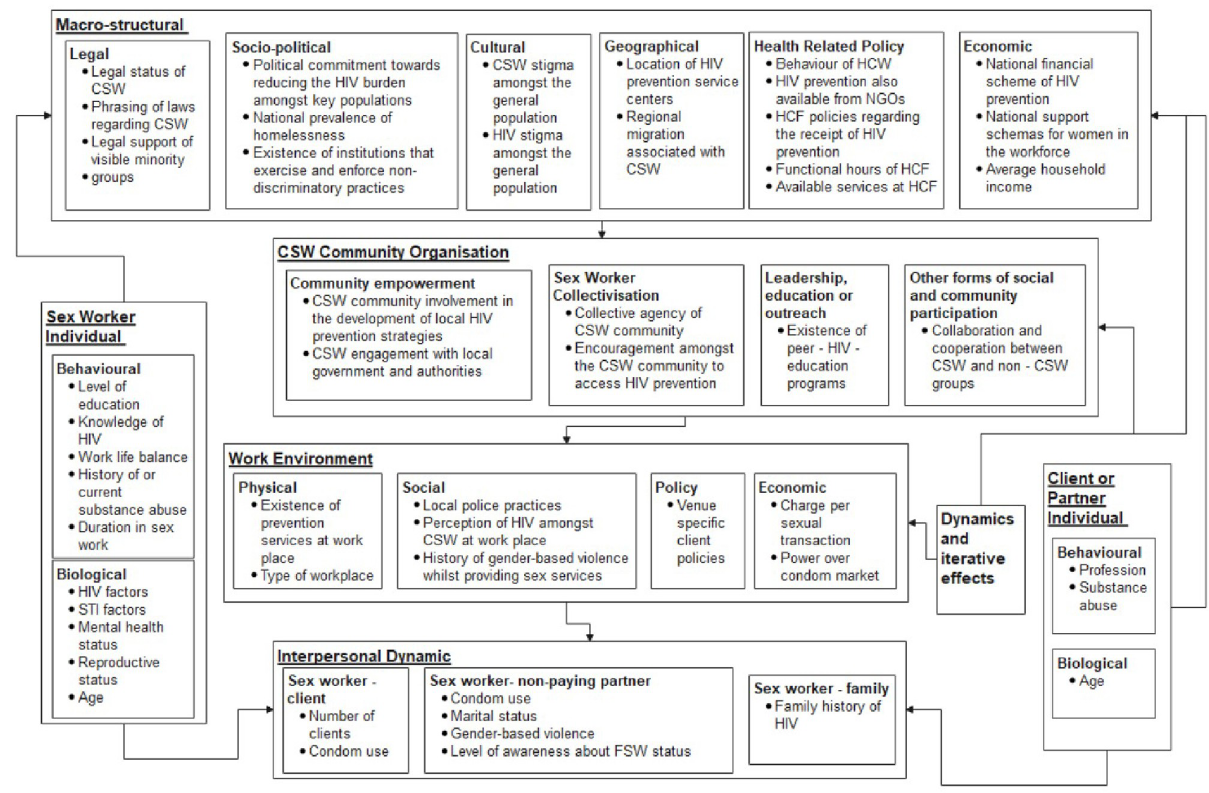
Fig 2. Conceptual framework of factors and structural levels influencing access to HIV prevention.